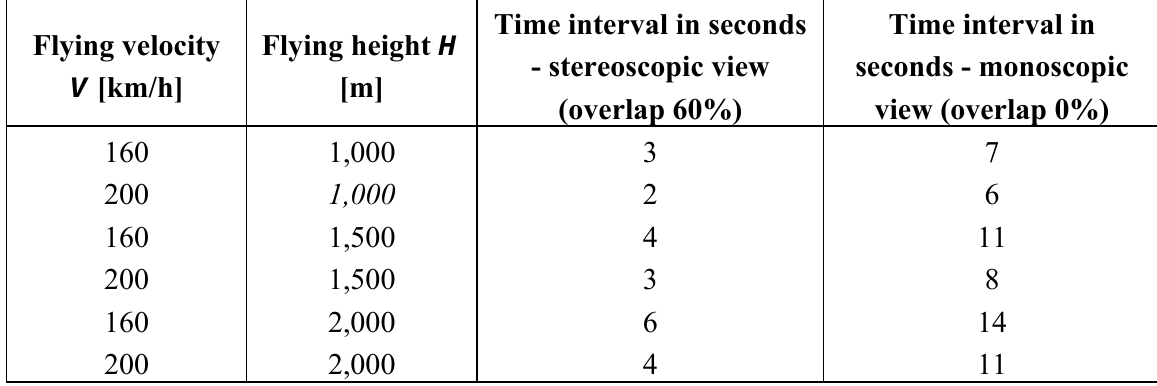
Table 4 . Time interval of successive image acquisitions for different combinations of flying velocity, flying height and image overlap percentage. FPA physical dimension l = ( 6,24mm) x w (